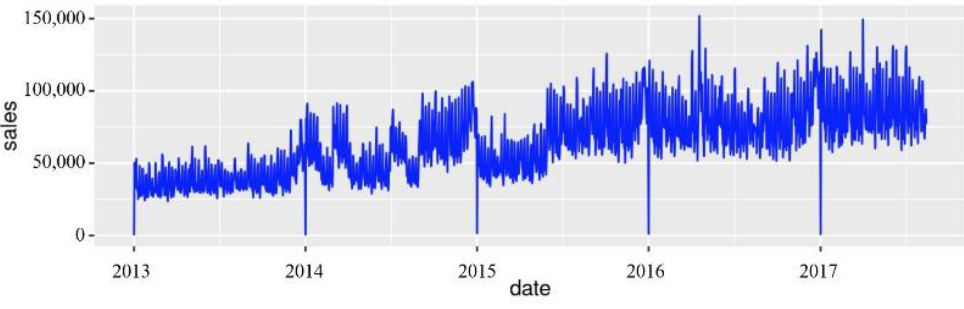
Figure 1. Total sales trends over time.